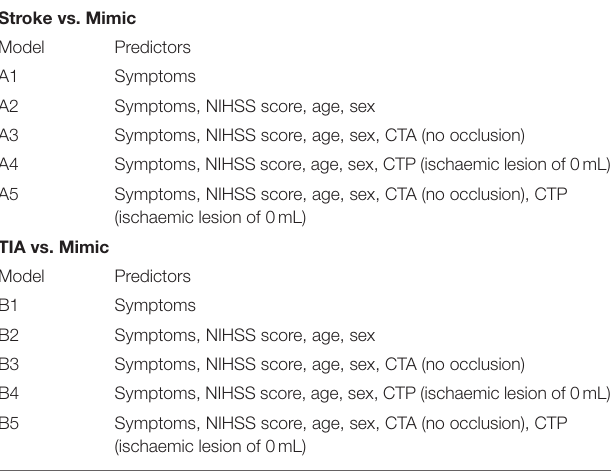
TABLE 1 | Predictors used in logistic regression models for stroke vs. mimic and transient ischaemic attack vs. mimic. Stroke vs.